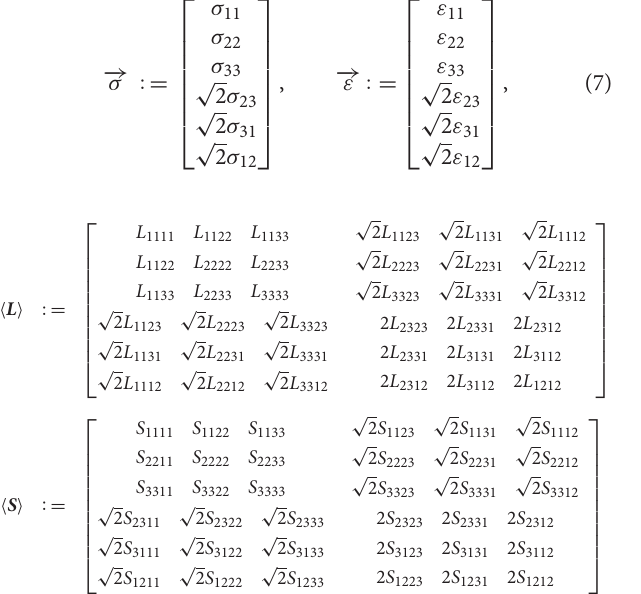
ν 0 10 E 0 and ν 1 0.25 and = = =